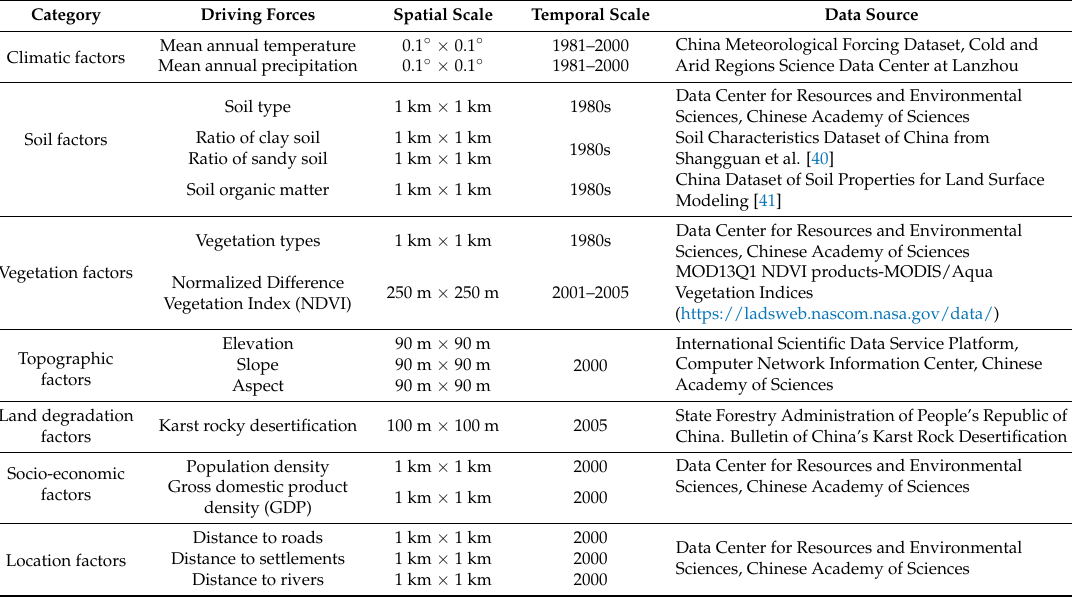
Table 1. Data sources and description of driving